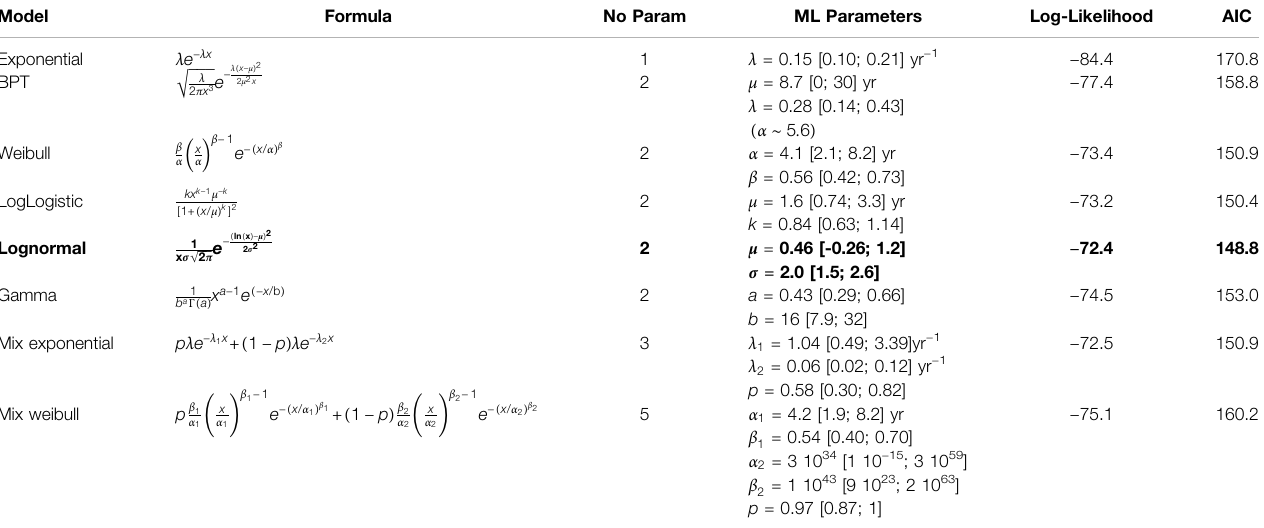
TABLE 1 | Renewal models fi t to the IETs data ( x in years), considering the censoring information of no failure at the date of December 31, 2019. Model